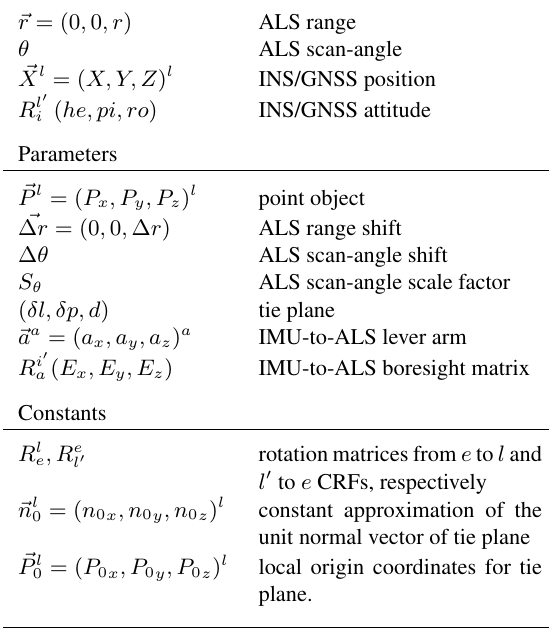
Table 3: Symbols in the FC line coplanarity